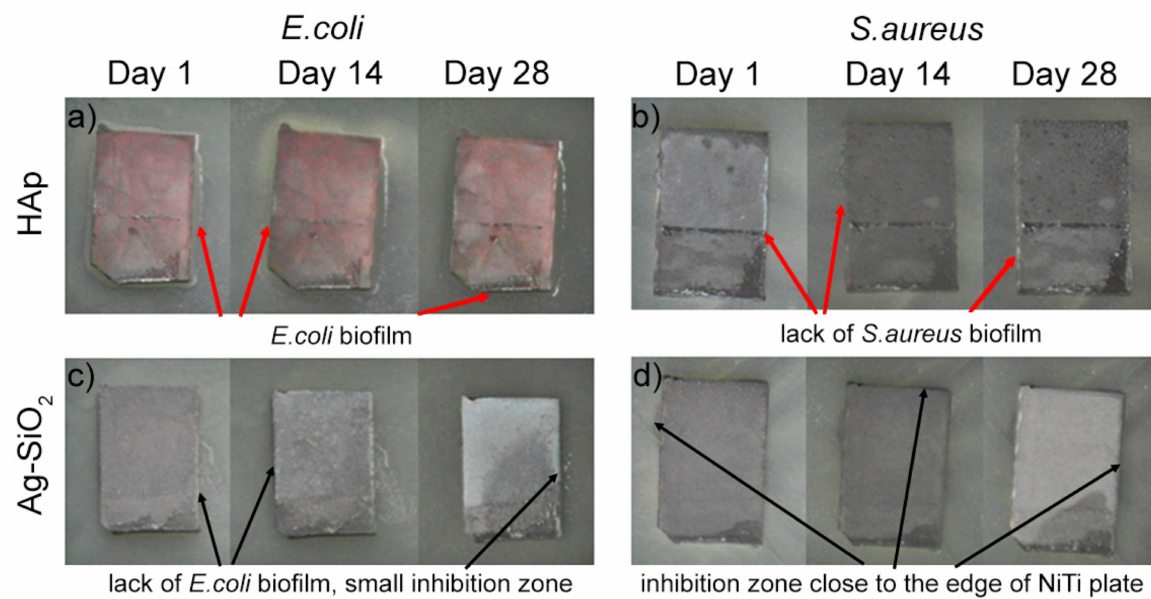
Figure 2. Effect of the ( a,b ) HAp and ( c,d ) Ag-SiO 2 coatings functionalized the passivated NiTi alloy on the growth of Gram-negative bacteria Escherichia coli ( left panels) and Gram-positive bacteria Staphylococcus aureus ( right panels). The appearance of biofilm that overgrows the edge of NiTi alloys, or its lack of, is red arrow marked. Inhibition zone close to the edge of alloys is black arrow highlighted. The experiment was evaluated after 1, 14 and 28